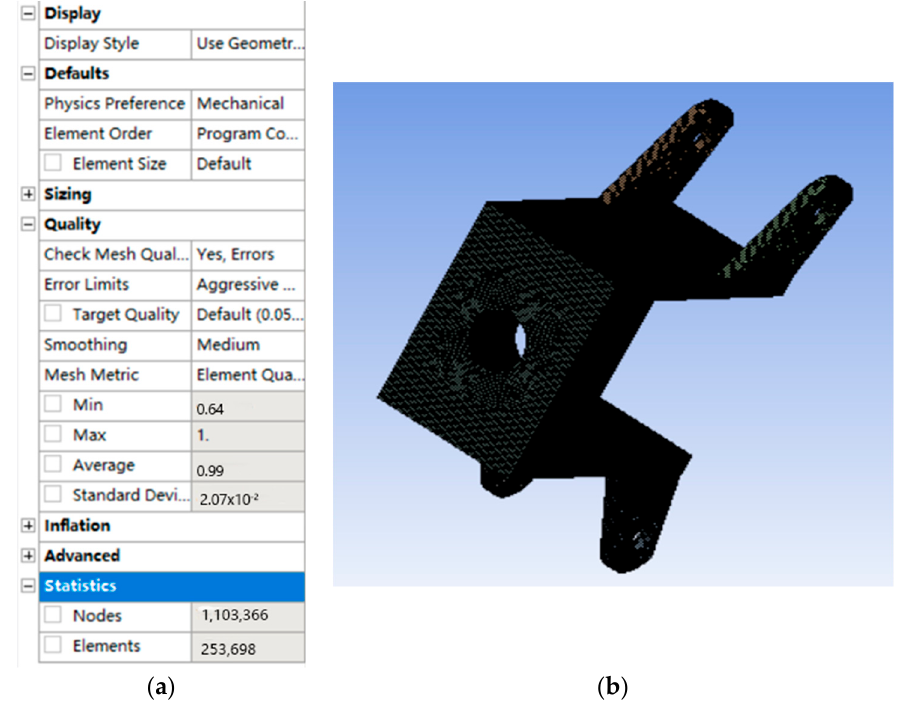
Figure 29. Mesh division and mesh quality of rear wheel connector. ( a ) Element quality of the mesh, ( b ) Effect picture of meshing.